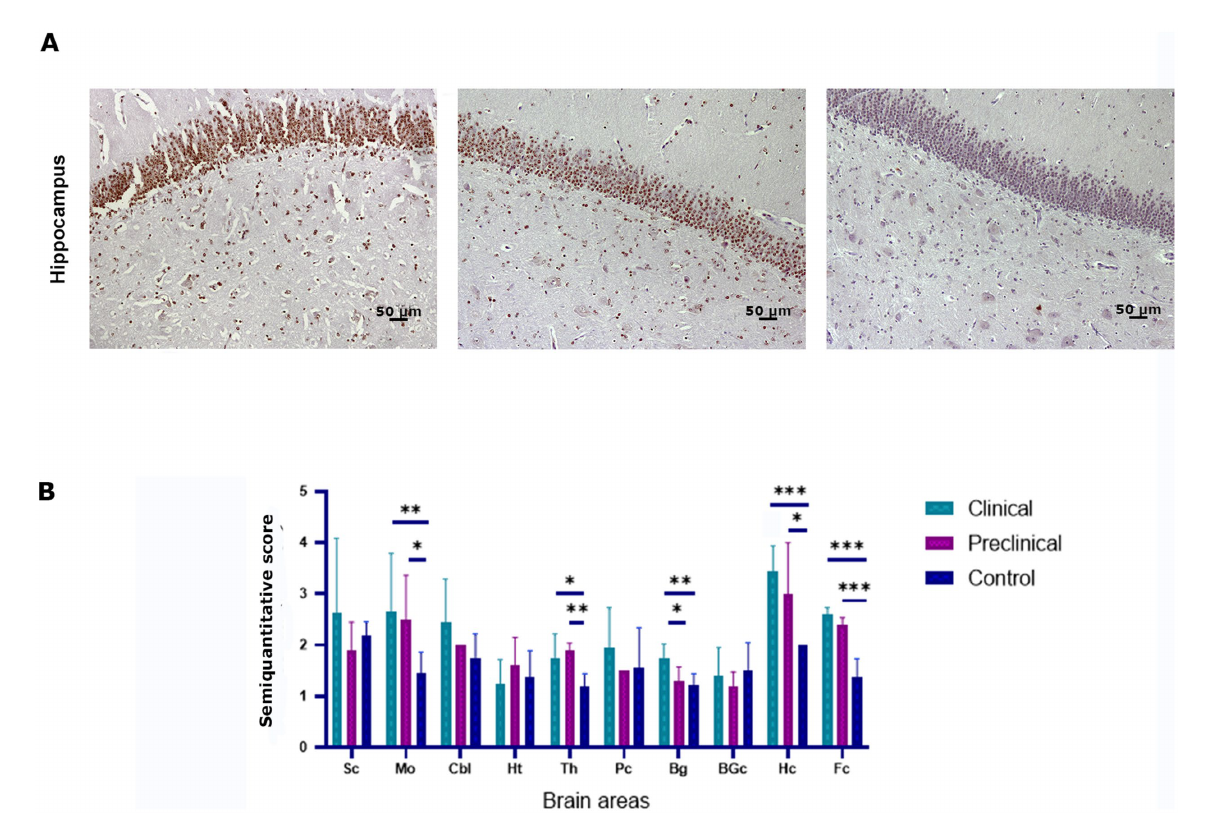
FIGURE 4 Ubiquitin accumulation in clinical and preclinical scrapie-infected sheep and healthy sheep. (A) Ubiquitin-protein intraneuronal aggregates are observed in the hippocampus. The CA1-CA2 regions of the hippocampus showed the strongest immunostaining for ubiquitin in clinical and preclinical sheep. (B) Expression levels of ubiquitin protein in eight clinical, five preclinical and eight control animals were semiquantitatively evaluated using a scale of 0 (lack of immunostaining) to 5 (very intense immunostaining) in nine brain areas: [spinal cord (Sc), medulla oblongata (Mo), cerebellum (Cbl), hypothalamus (Ht), thalamus (Th), parietal cortex (Pc), basal ganglia (BG), cortex at the level of basal ganglia (BGc), hippocampus (Hc) and frontal cortex (Fc)]. Comparison of Ubiquitin immunolabeling revealed significant differences between clinical and control sheep in several brain areas. Preclinical animals showed higher levels of ubiquitin accumulation in the frontal cortex, thalamus (** p < 0.01) medulla oblongata and hippocampus (* p < 0.05) when compared to controls. Clinical and preclinical animals showed significant differences in the basal ganglia area. Comparison of means was analyzed using the nonparametric Mann–Whitney U test.